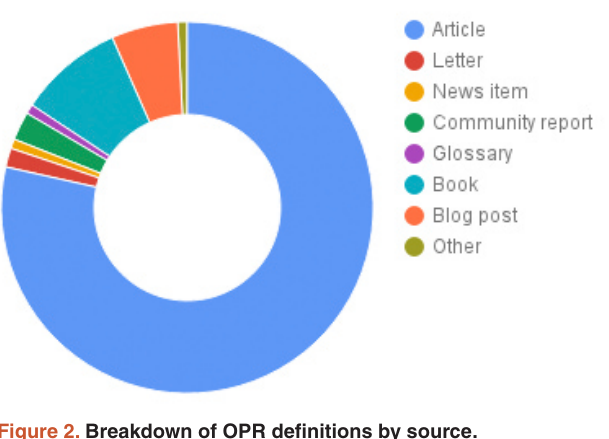
Figure 2. Breakdown of OPR definitions by source.